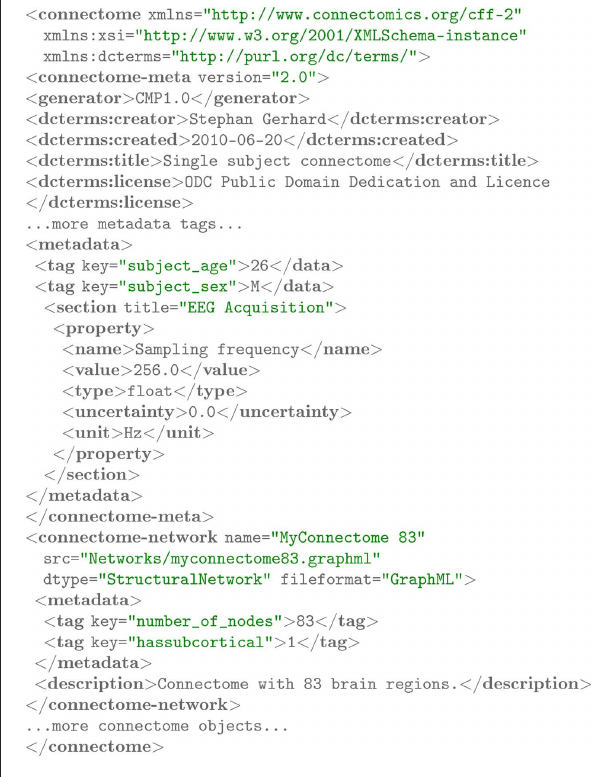
Figure 6 | The content of a meta.cml file.